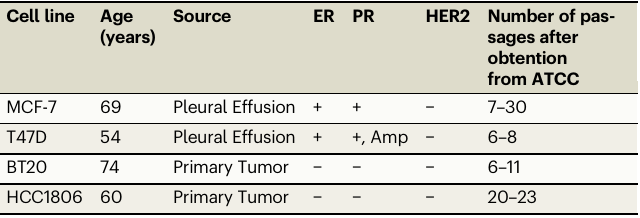
Table 1 | Cell lines used in this